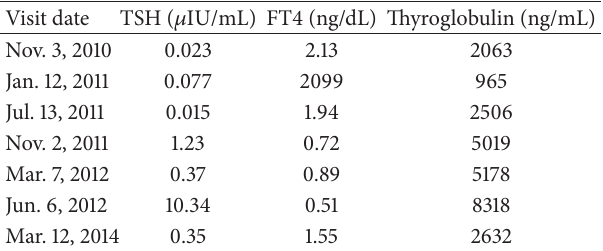
Table 1: Thyroid function tests and thyroglobulin levels from Nov. 2010 to Mar. 2014.